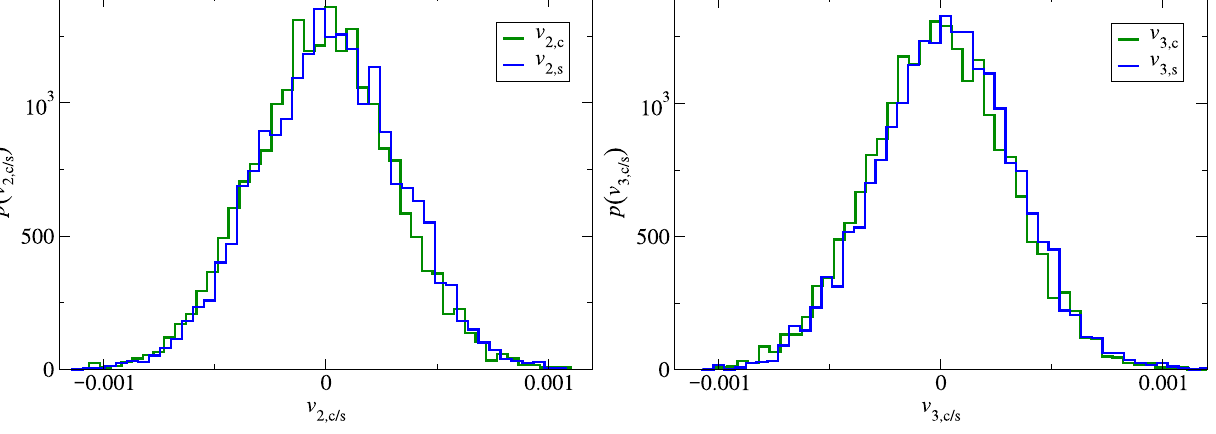
Fig. 8 Probability distribution of v 2 , c / s (left) and v 3 , c / s (right) in the initial state of the transport algorithm computed for 5000 events at b = 9 fm